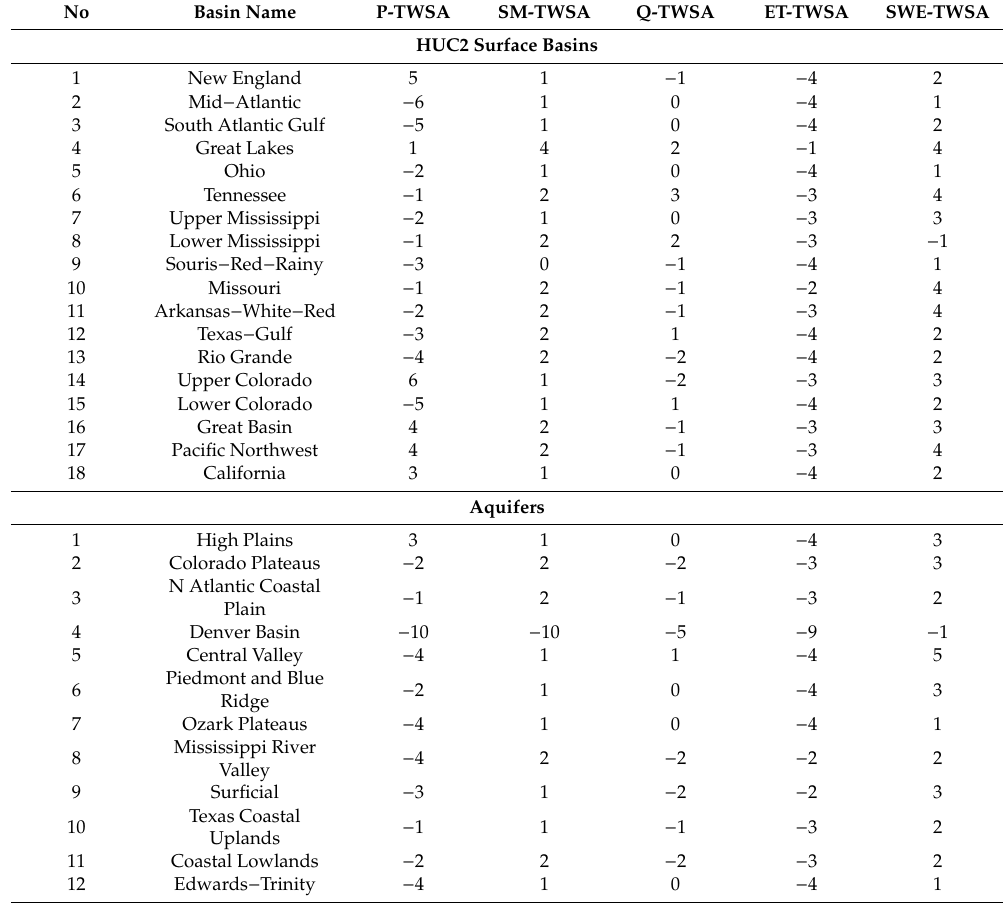
Table A1. Analysis of TWSA lag against other hydrologic